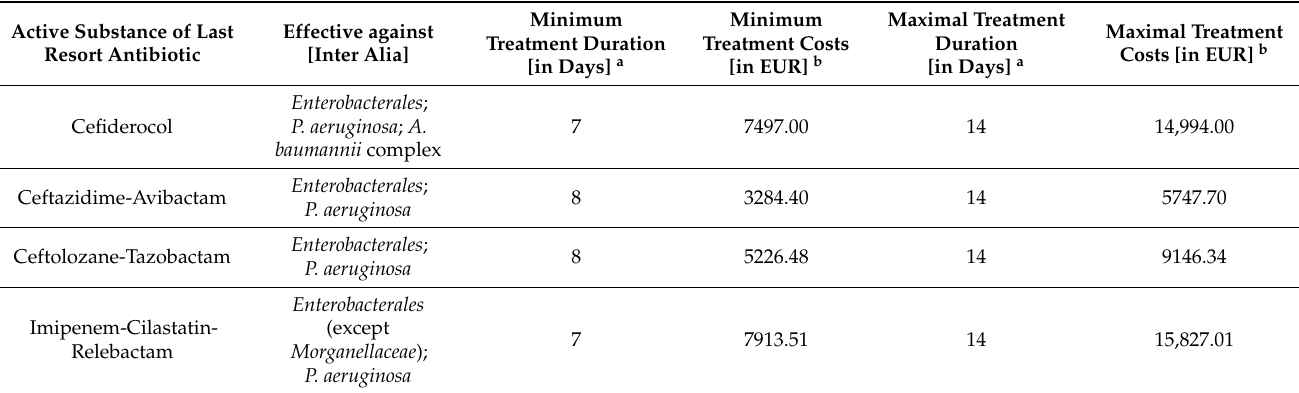
Table 2. Last resort antibiotic acquisition costs by treatment